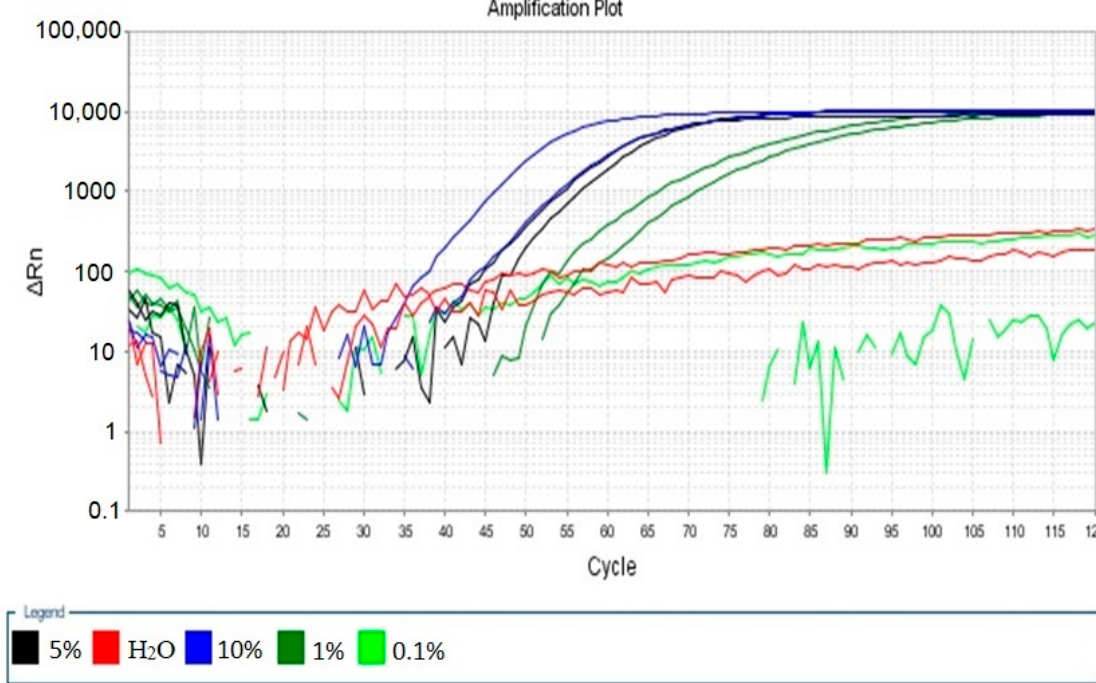
Figure 4. The detection limit of the real-time LAMP Assay. 10%: DNA extracted from sweet potato starch containing 10% cassava starch; 5%: DNA extracted from sweet potato starch containing 5% cassava starch; 1%: DNA extracted from sweet potato starch containing 1% cassava starch; and 0.1%: DNA extracted from sweet potato starch containing 0.1% cassava starch.